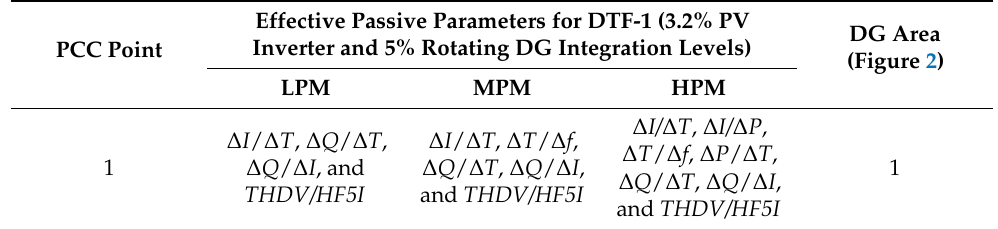
Table 7. Summarization of the effective passive parameters obtained from the proposed MAAC